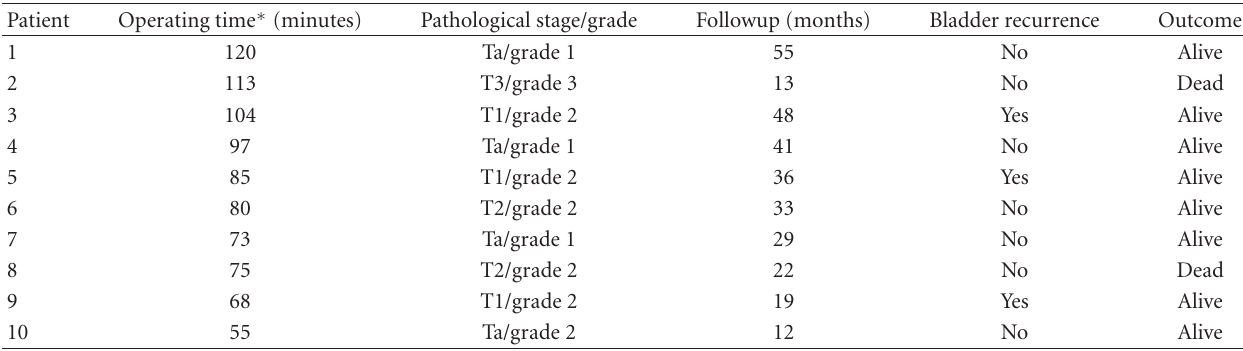
Table 2: Intra- and postoperative